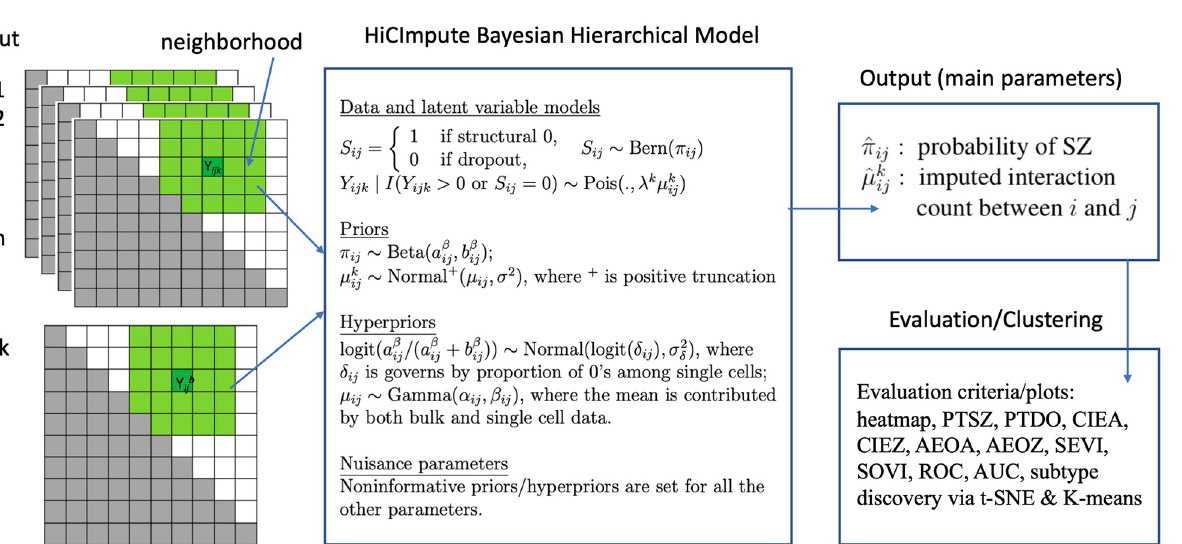
denotes whether an ij